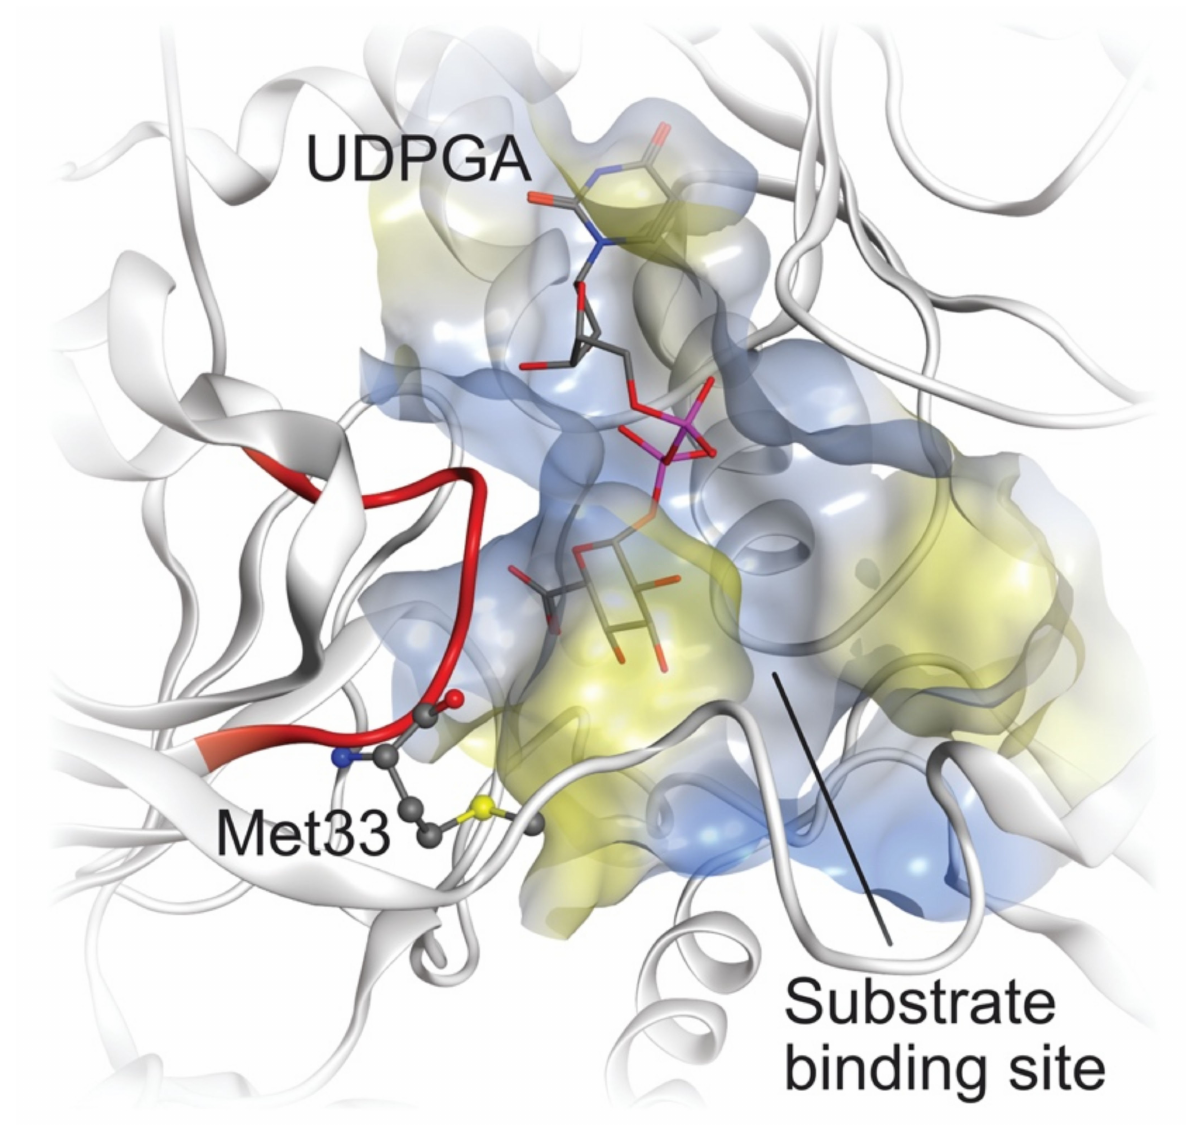
Figure 7. UGT1A7 binding site with receptor surface and cofactor (UDPGA) presented. The loop of residues 32–38 was colored red, and Met33 was shown in the ball and stick